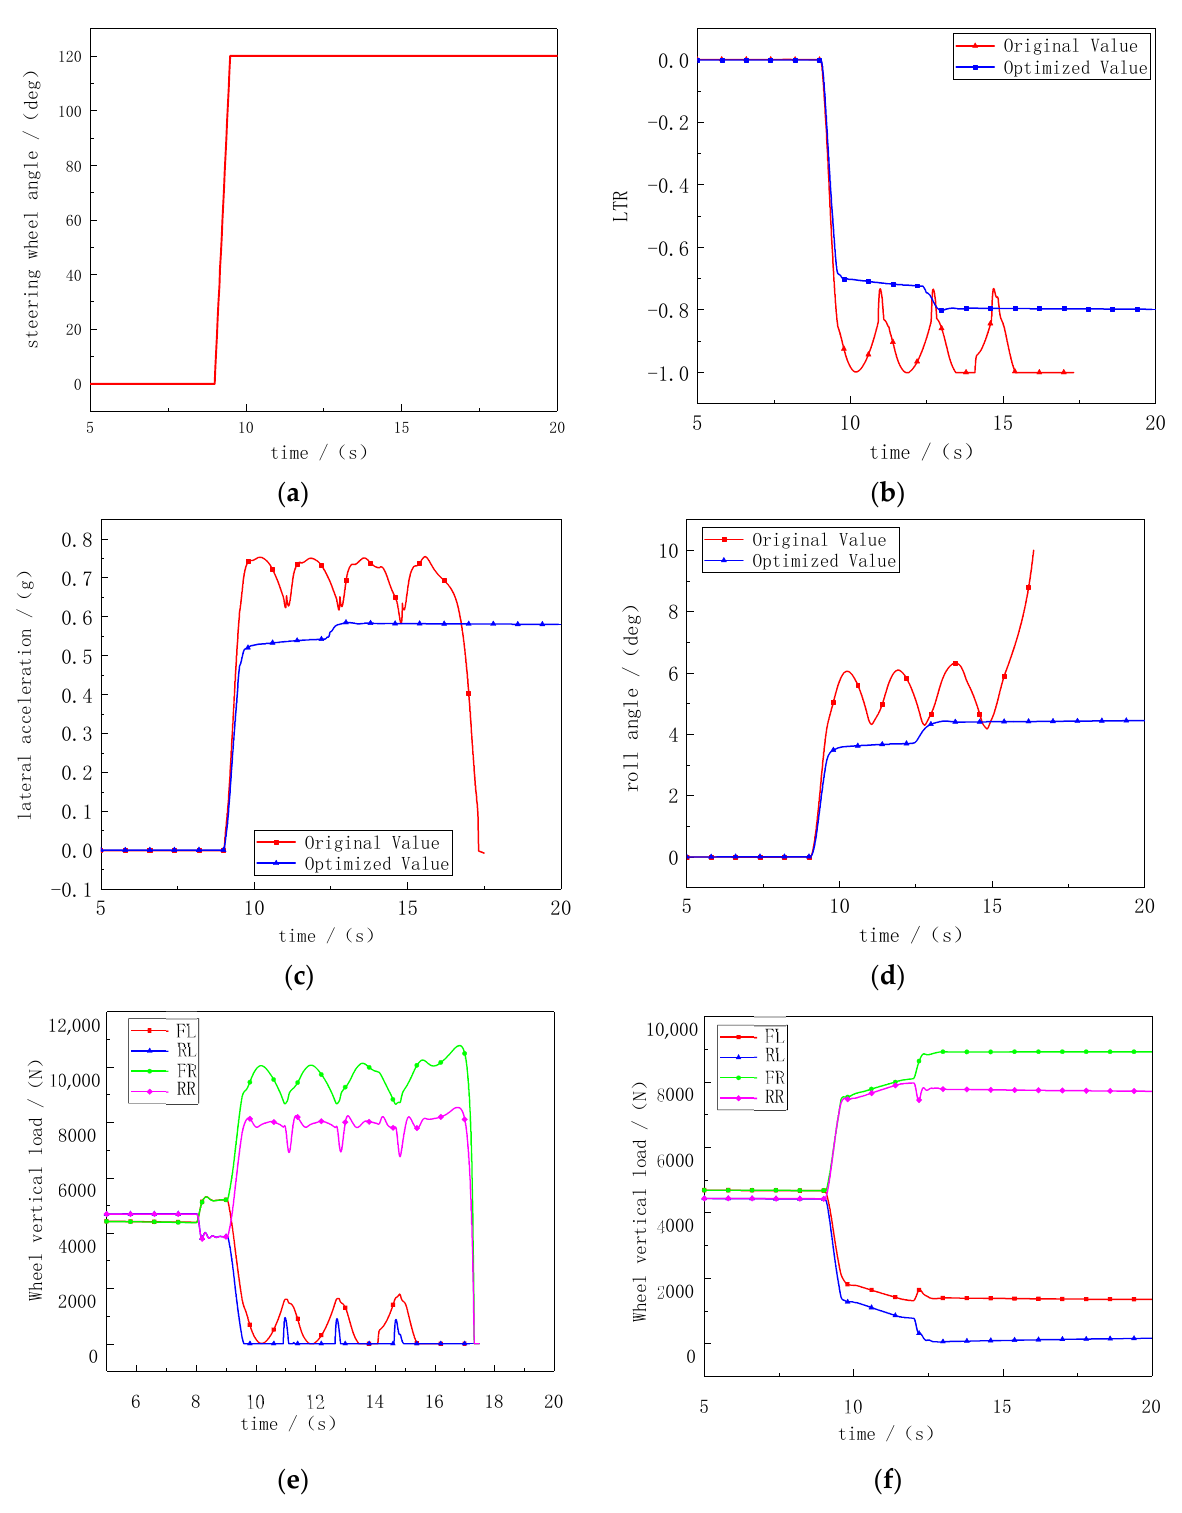
Figure 8. Simulation results of J-turn condition. ( a ) Steering wheel angle. ( b ) LTR. ( c ) Lateral acceleration. ( d ) Roll angle. ( e ) Wheel vertical load before control. ( f ) Wheel vertical load after control.